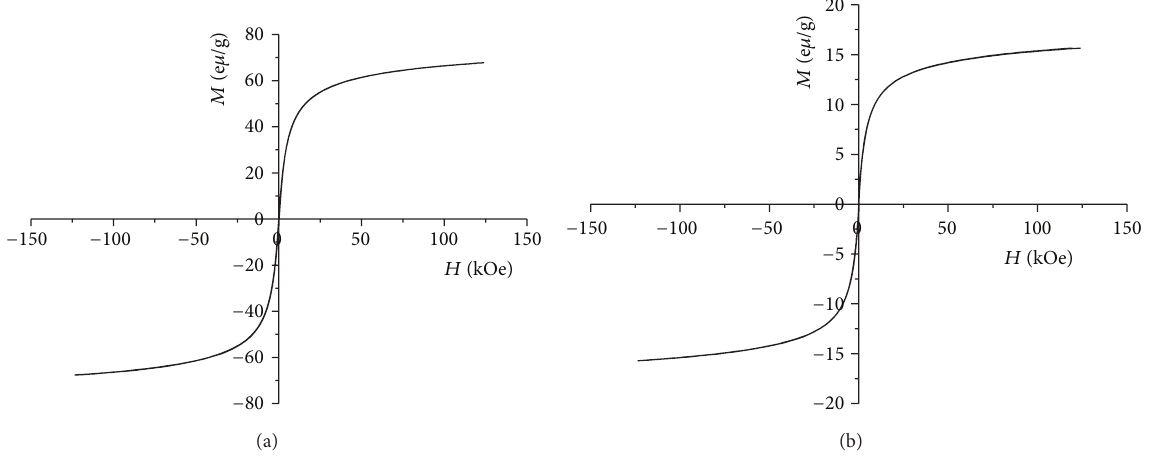
Figure 4: The magnetization curve of (a) Fe 3 O 4 core and (b) TSF